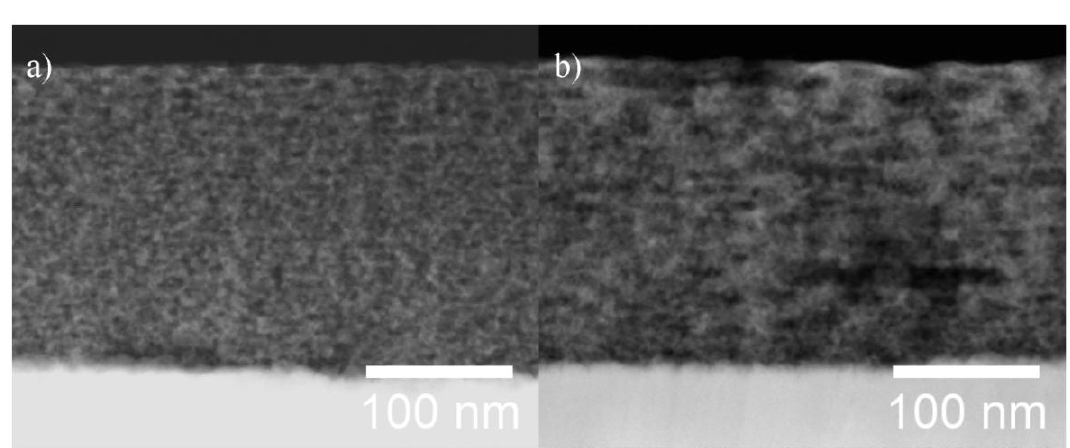
Figure 4. STEM dark field image of mesoporous ITO films prepared with the block copolymer PIB-PEO 3000 ( a ) and PIB-PEO 20000 ( b ) in cross section after 10 s of ZnO electrodeposition. In both cases no ZnO crystals are observed on top of the